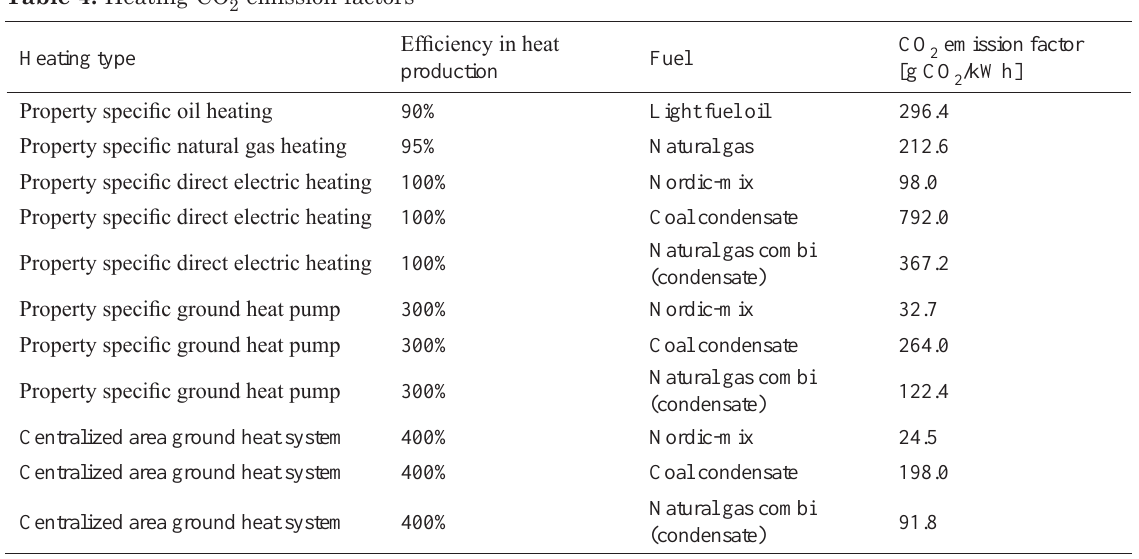
table 4. heating co